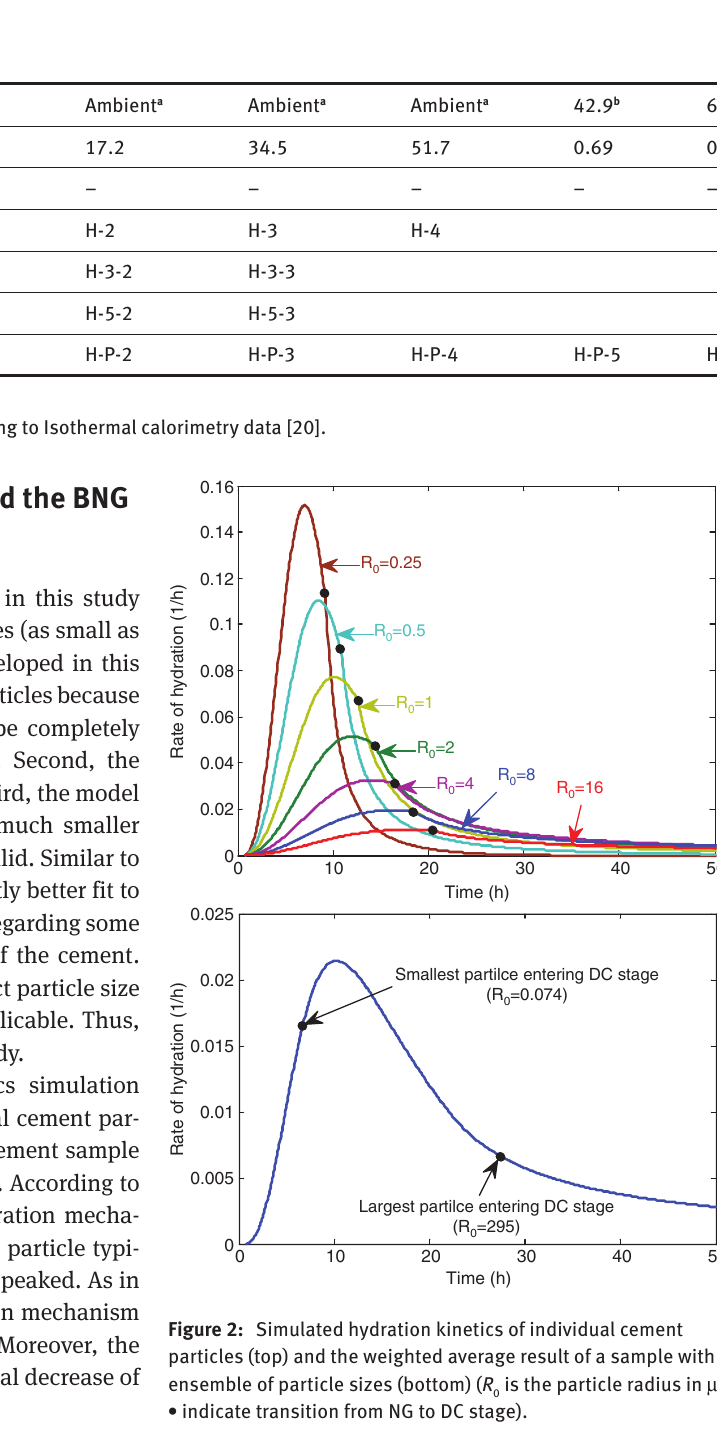
a Ambient temperature in the lab.